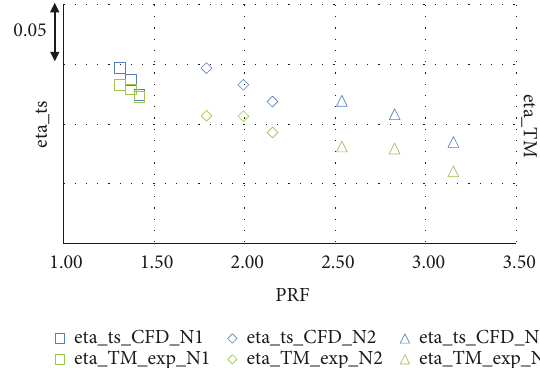
Figure 6: 𝜂 ts vs PRF in full admission, CFD (blue) and experimental data